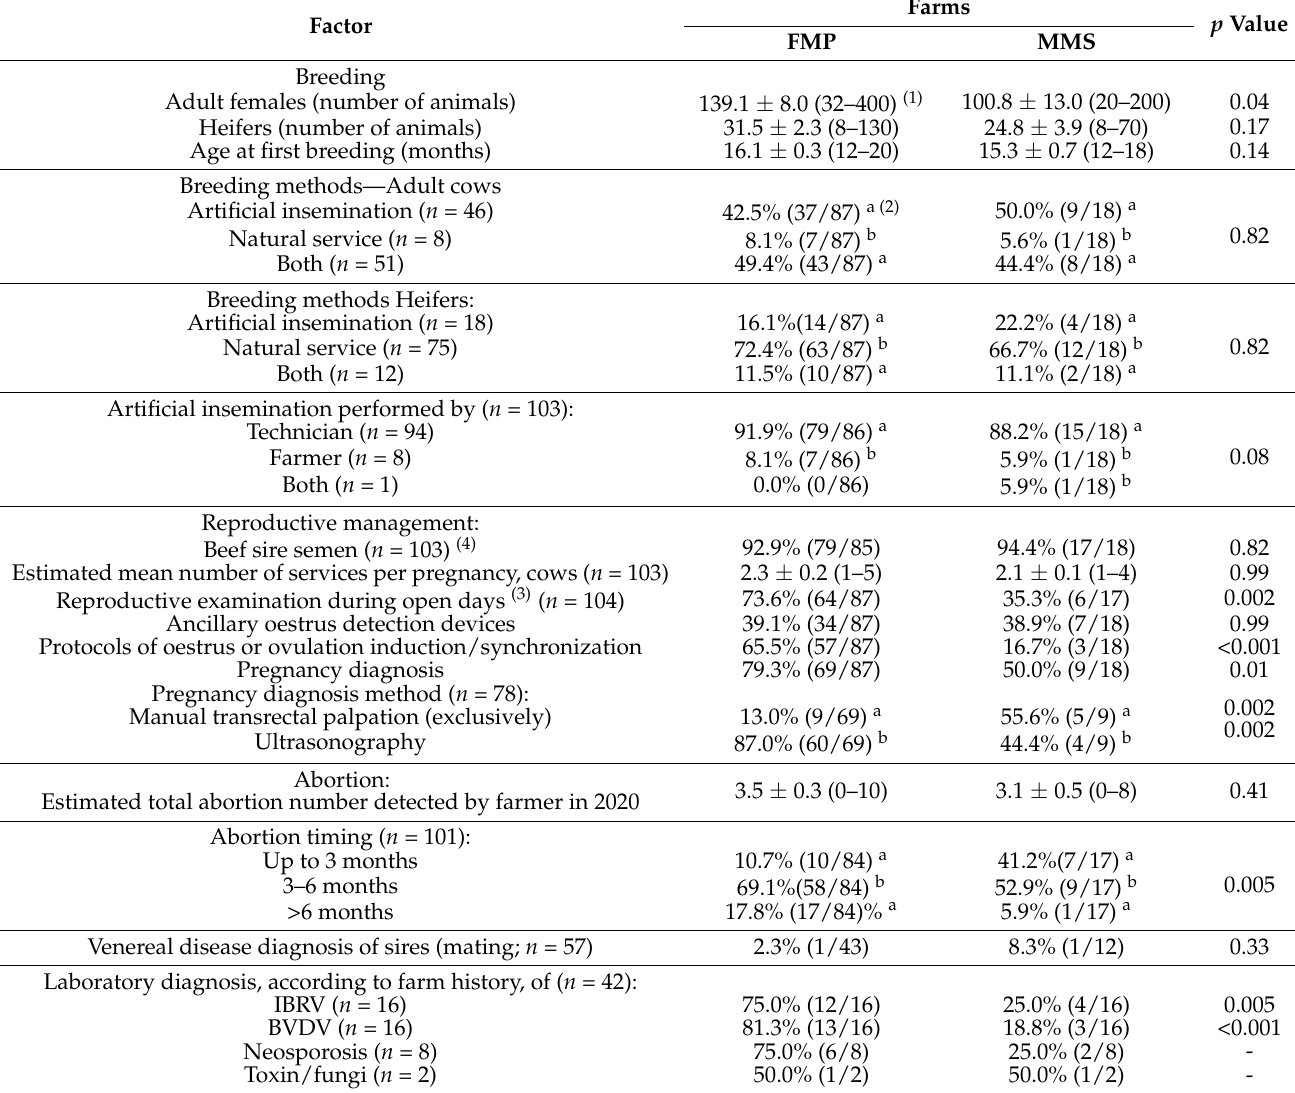
Table 1. Reproduction management in dairy farms with fixed (FMP) and mobile (MMS) milking